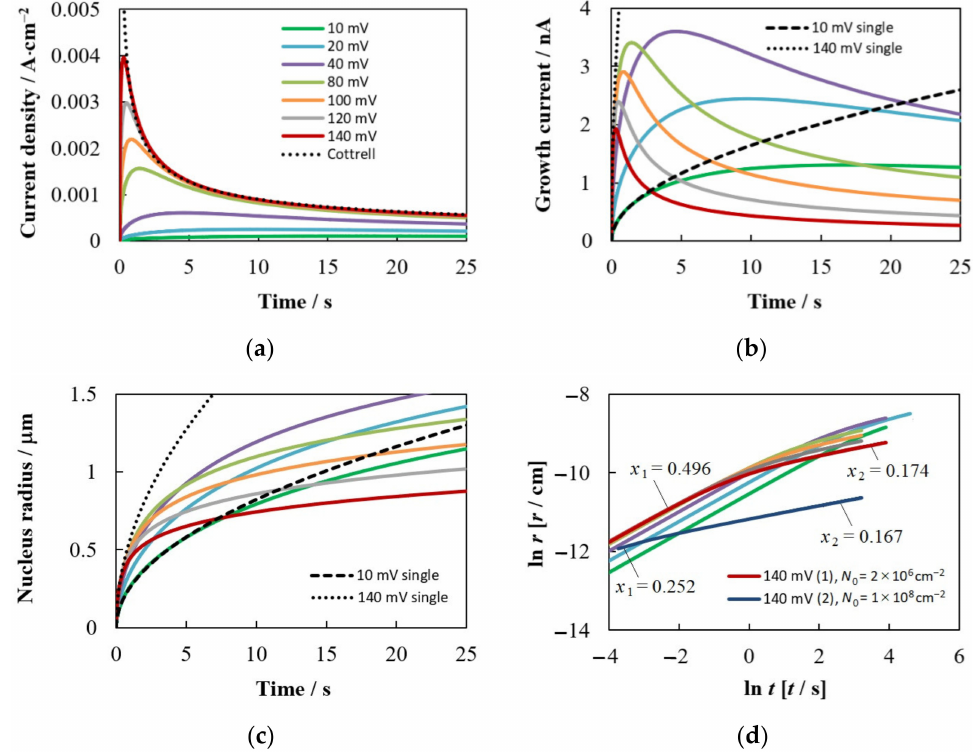
Figure 4. ( a ) Calculated potentiostatic current density transients, ( b ) time dependences of the growth current, ( c ) time dependences of the nucleus radius, and ( d ) logarithmic dependences of the nucleus radius on time for hexagonal ensembles. Designations of colored lines in ( b , c ) are given in ( a ). Parameter values are given in Section 2.3 and Table 1. The radius and growth current of a single nucleus were calculated using Equations (4) and (5), respectively. The cathode overpotential and current are considered positive in this